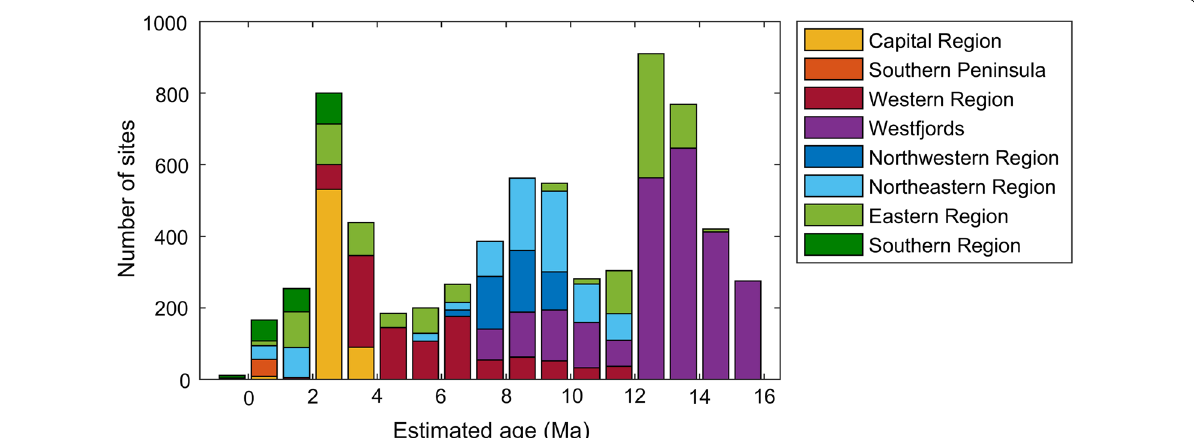
Fig. 7 Histogram of sites by age. Distribution of ICEPMAG sites across the 0–16 Ma age range, coloured by geographic region (legend inset). Sites with negative values ( < 0 Ma) indicate lavas erupted since the standard year AD 1950